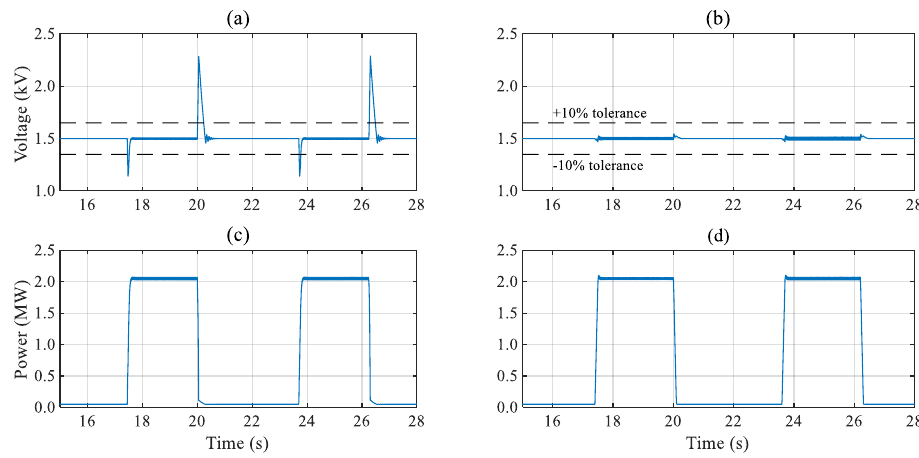
Figure 6. Output voltage and power response to 2 MW LDEW pulse with 100 ms rise time ( a , c ) without, and ( b , d ) with feedforward controller respectively.